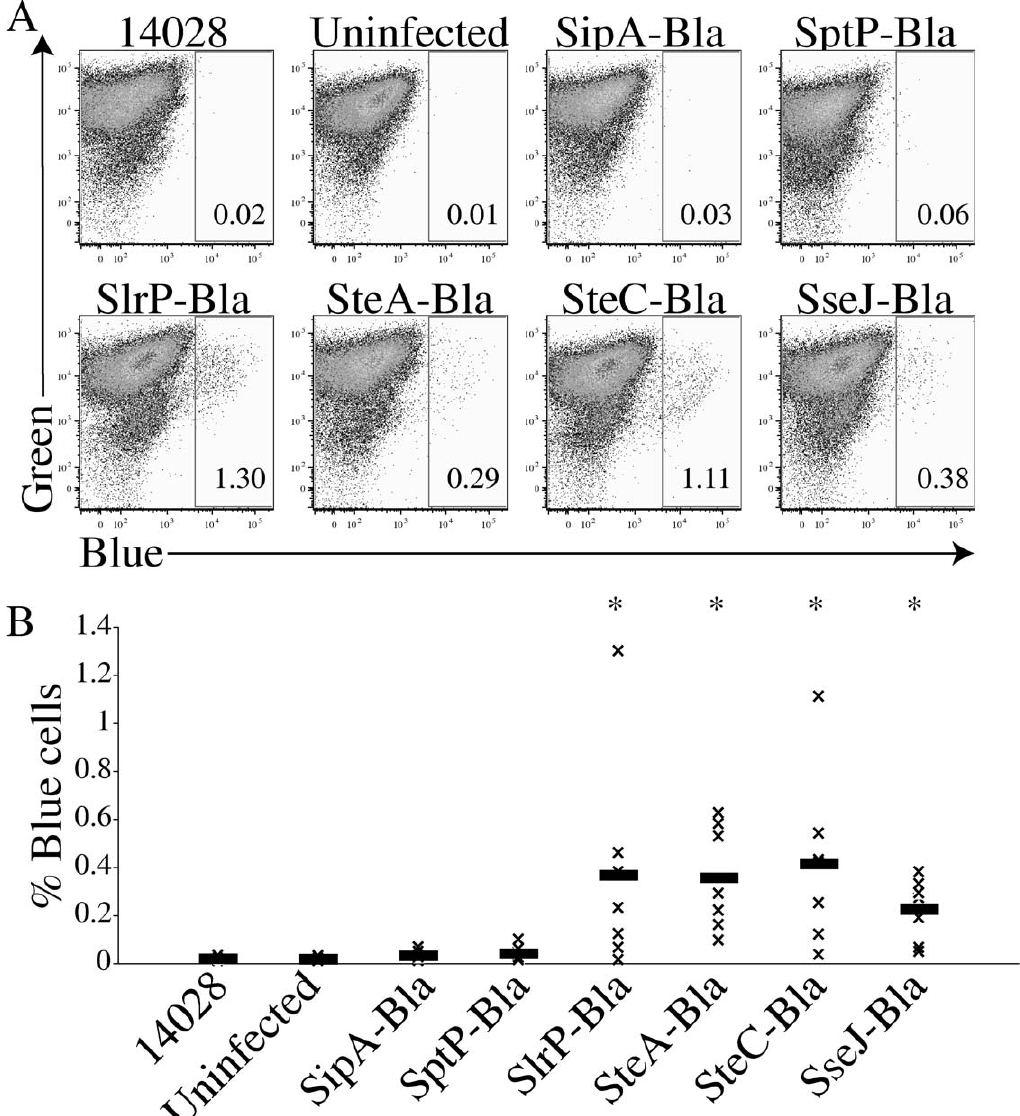
Figure 3. Detection of Secretion in C57BL/6 Spleen Cells FACS data with levels of green and blue CCF2-AM fluorescence in spleen cells from mice infected with each fusion strain (A). Green fluorescence indicates CCF2-AM is present within the cells. The percentage of blue cells, positive for secretion, is shown in the lower right corner of each dot plot. The graph below shows the percentage of total spleen cells emitting blue fluorescence as detected by FACS analysis (B). Each X represents the value for one mouse infected with the indicated strain and horizontal bars represent the average value of seven mice. The * denotes samples for which the Student’s t -test returned a value where p , 0.05 when compared to 14028-infected mice.